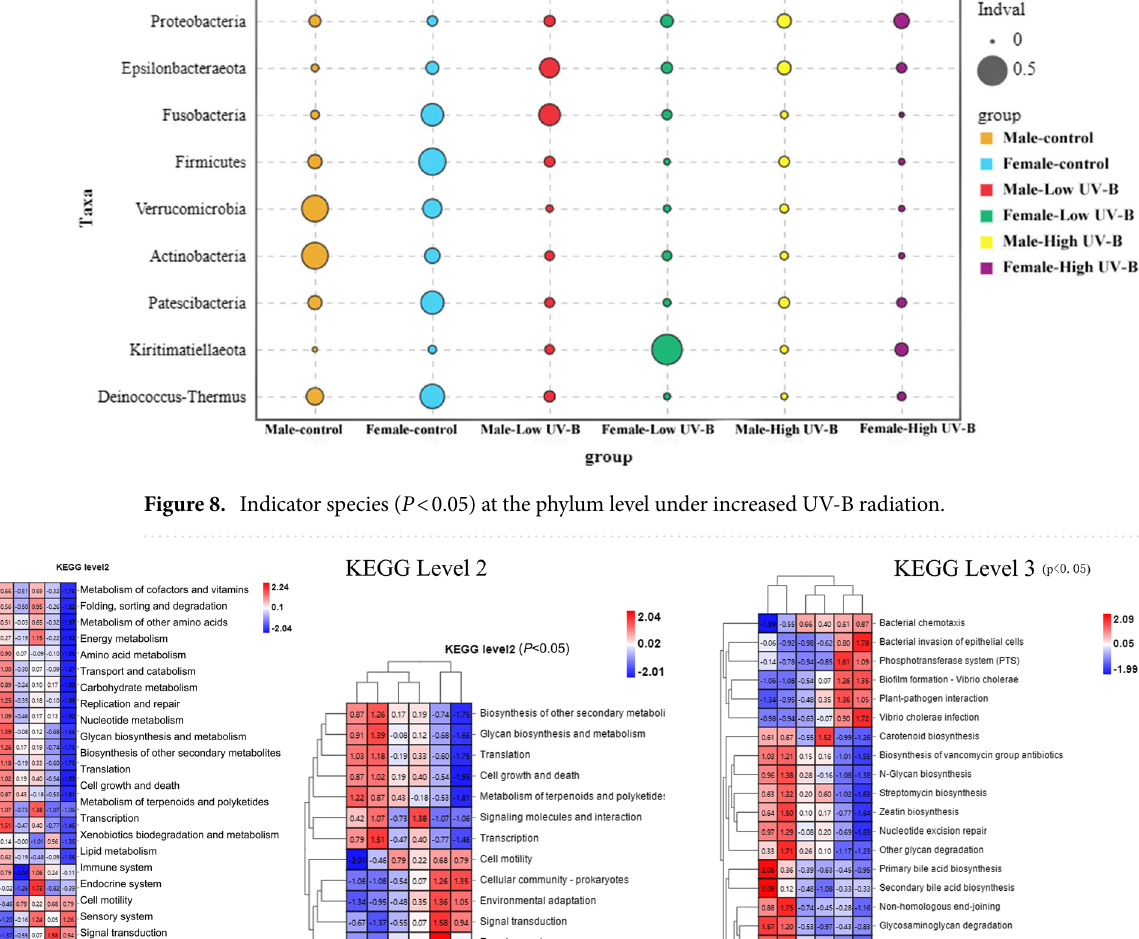
the radiation dose increased, the abundance of 11 genes with predicted functions related to metabolism (Strep- tomycin biosynthesis, N-glycan biosynthesis, glycosaminoglycan degradation, etc.) and 4 genes with predicted